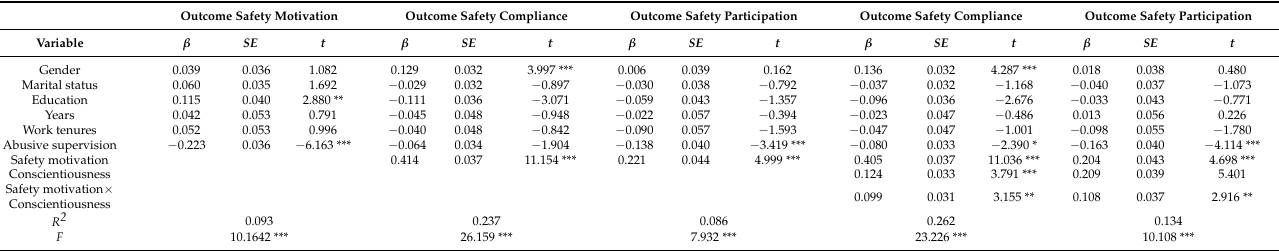
Table 3. Hierarchical regression